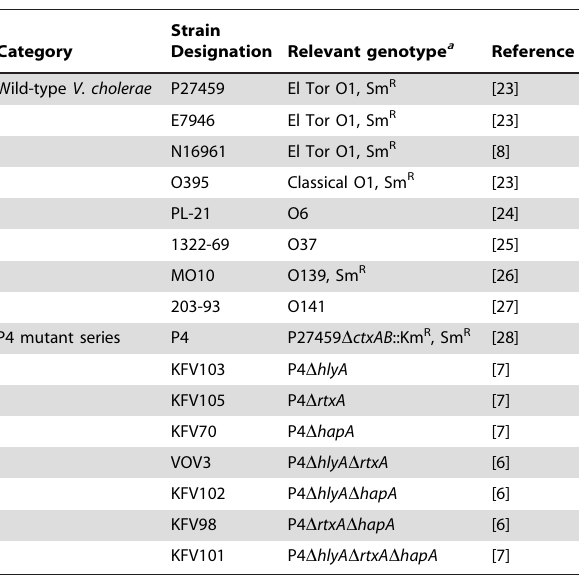
Table 1. Bacterial strains used in this